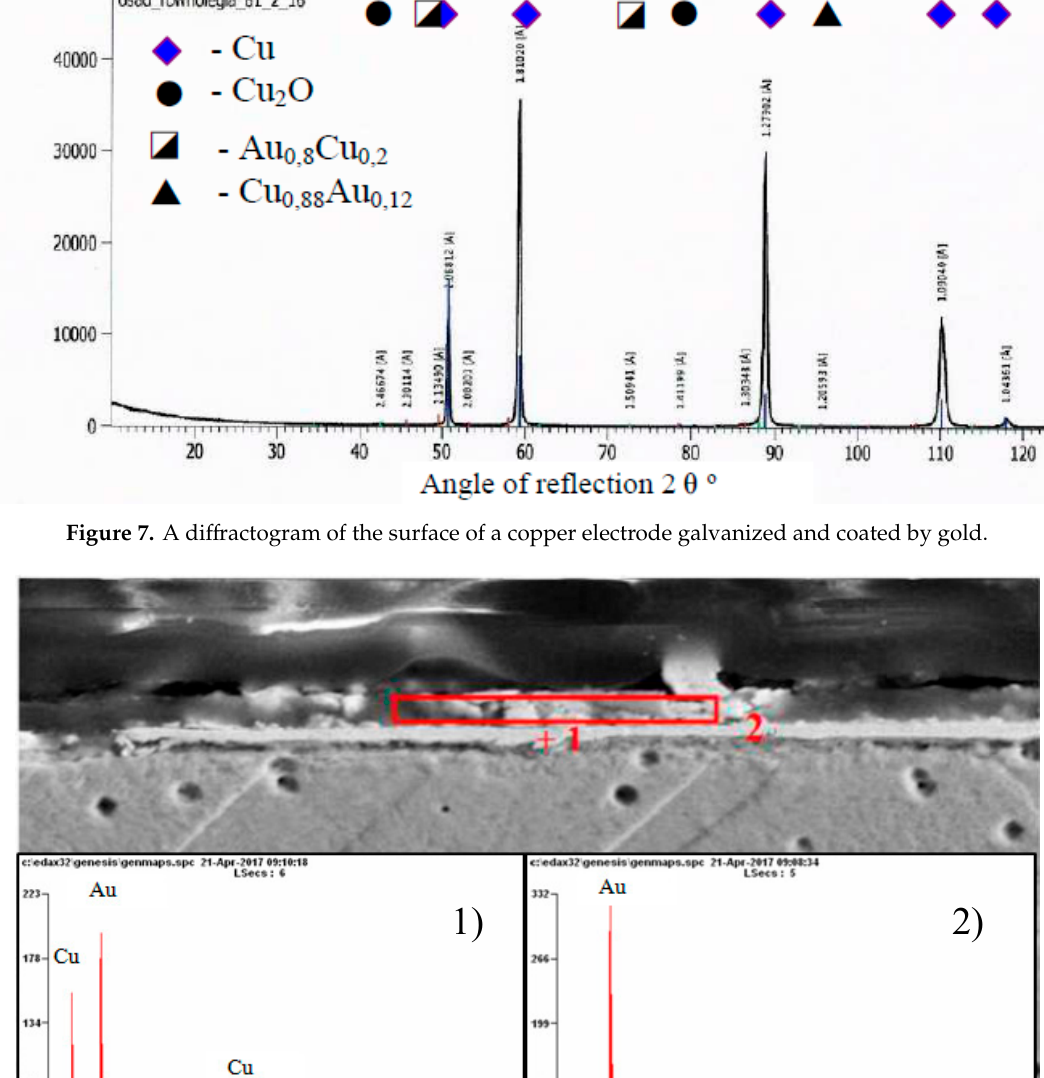
Figure 6. Gold electrode photography.